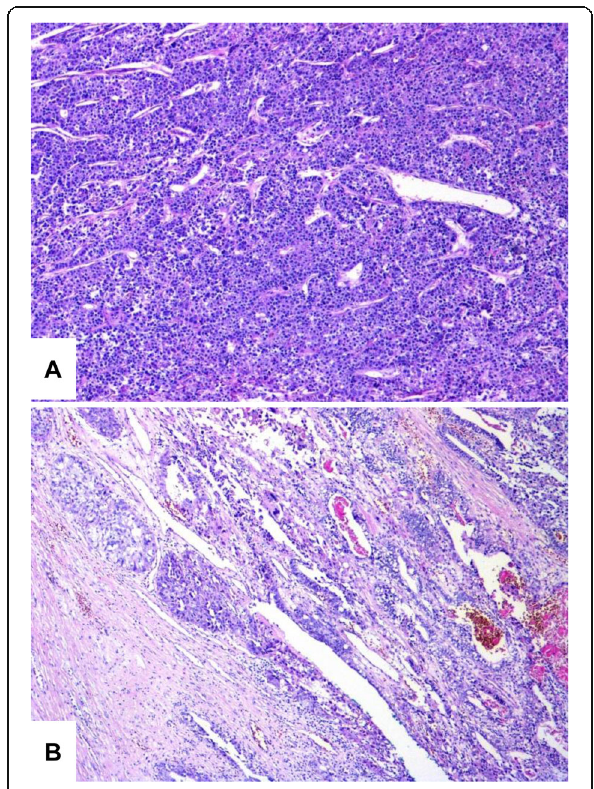
Fig. 3 A Histological findings from the resected tumor specimen showed a solid trabecular, sporadically glandular and cystically arranged malignant tumor of germinal appearance. B The transition to urothelium was abrupt, without any dysplasia or in situ change of the